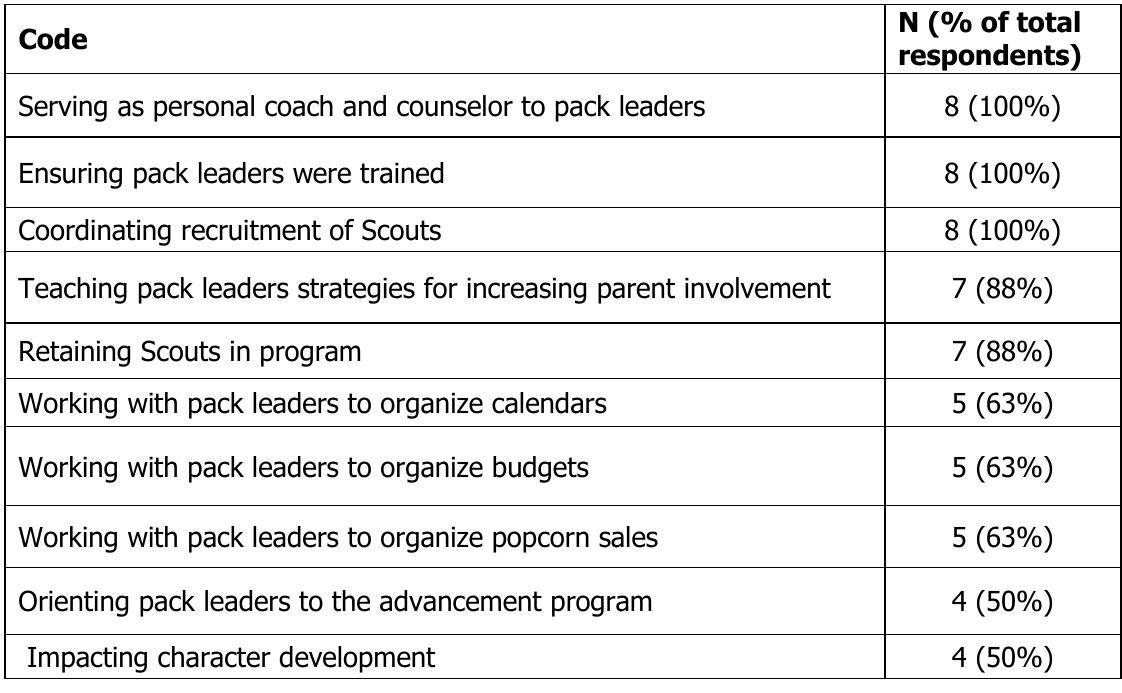
Codes Applied to Quality Unit Executive (QUE) Interview Responses about Definitions